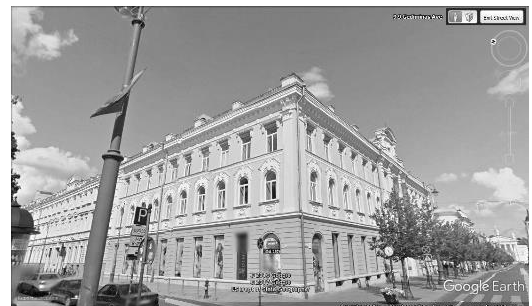
Figure 24. Gediminos 9 mall center, ancient Town Hall, Vilnius